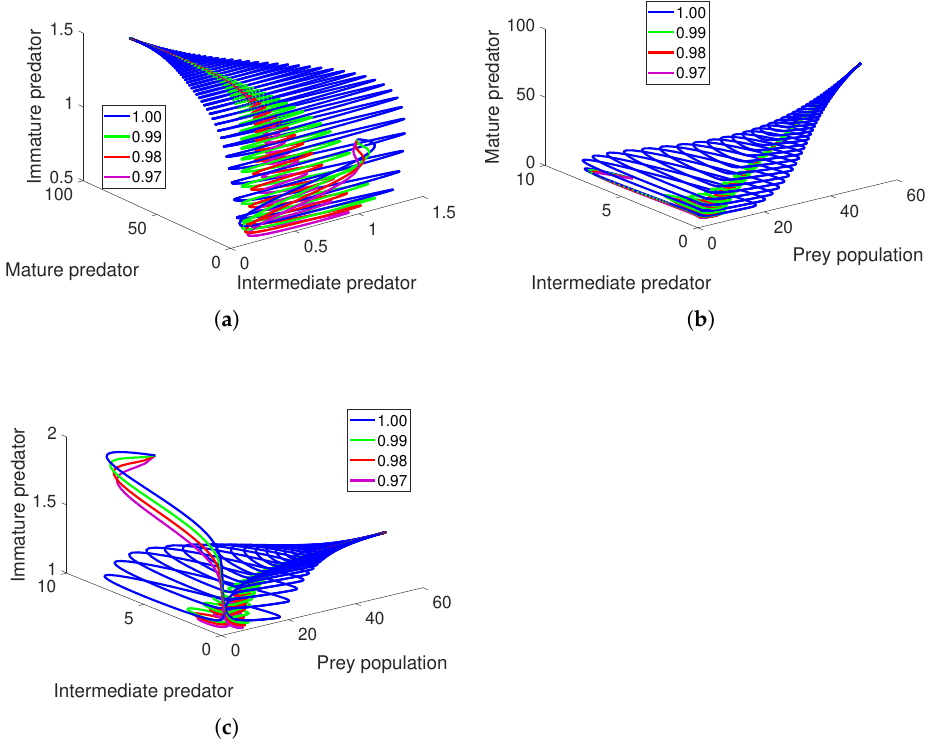
Figure 4. The 3D behavior of different phase planes of model (2) with various fractional orders vs t . In Figure 5, the dynamical evolution of the different populations with different initial conditions is presented. The blue color shows the behavior of different populations with initial conditions [ W 1 , W 2 , W 3 , W 4 ] = 10, 8, 6, 4, green color shows the dynamics with initial conditions 8, 6, 4, 2, and red curves show the evolution with initial conditions 6, 4, 6, 8. In Figure 5a, the population dynamics of intermediate, mature and prey, intermediate predators are depicted, respectively, with d = 1.00. Similarly, Figure 5b,c shows the population behavior of intermediate, mature and prey, intermediate predators, respectively, with d = 0.97. It can be observed that, at lower fractional orders, the complexity in the dynamics is reduced, and the system moves towards stability quickly as compared to higher fractional orders. From the simulations, it is observed that, at higher fractional orders, there are a number of oscillations in the system, and it behaves chaotically, while, at lower fractional orders, the amplitudes of oscillations decrease, resulting in faster converging towards the equilibrium